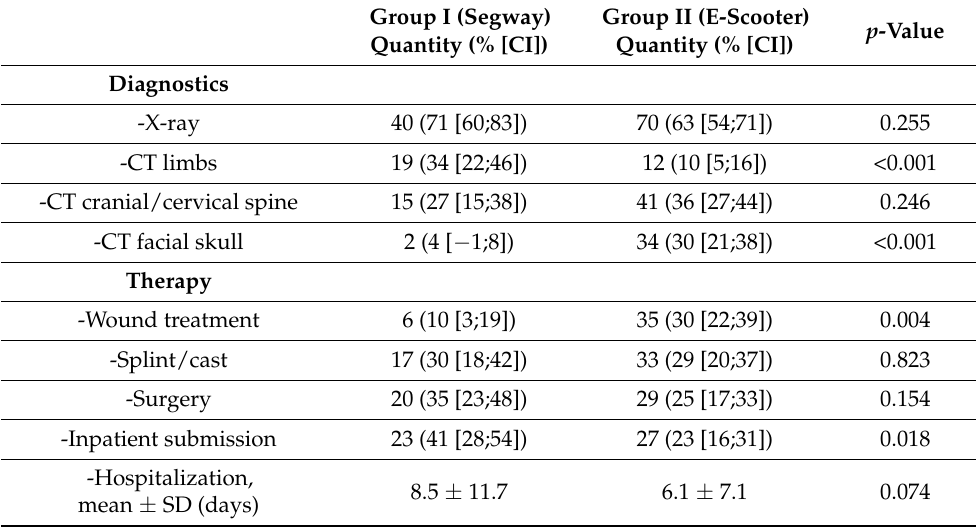
Table 4. Diagnostics/therapy in emergency room and following